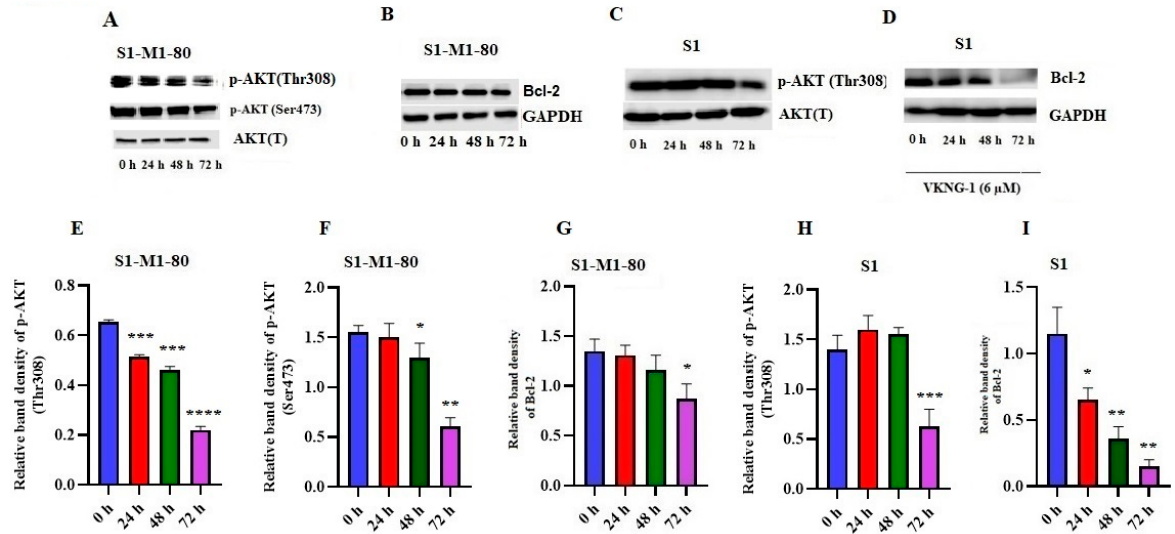
Figure 6. Effect of VKNG-1 on the expression of p-AKT and BCl-2 in S1 and S1-M1-80 cells: The relative intensity of p-AKT (Thr308 and Ser473) ( A ) and Bcl-2 ( B ) in S1-M1-80 cells and p-AKT (Thr308) ( C ) and Bcl-2 ( D ) in S1 cells after treatment with 6 µM of VKNG-1 for 24, 48 and 72 h. Relative quantification of the effect of VKNG-1 on p-AKT (Thr308) ( E ), Ser473 ( F ) and Bcl-2 ( G ) in S1-M1-80 cells and Thr308 ( H ) and Bcl-2 ( I ) in S1 cell line. The expression level of the target protein, Bcl-2 was normalized to GAPDH and the levels of p-AKT (Thr308 and Ser473) were normalized to AKT(T). Equal amounts of total cell lysates were employed for each sample and Western blot analysis was conducted. * p < 0.05, ** p ≤ 0.01, *** p ≤ 0.001 and **** p ≤ 0.0001 compared to the control group.